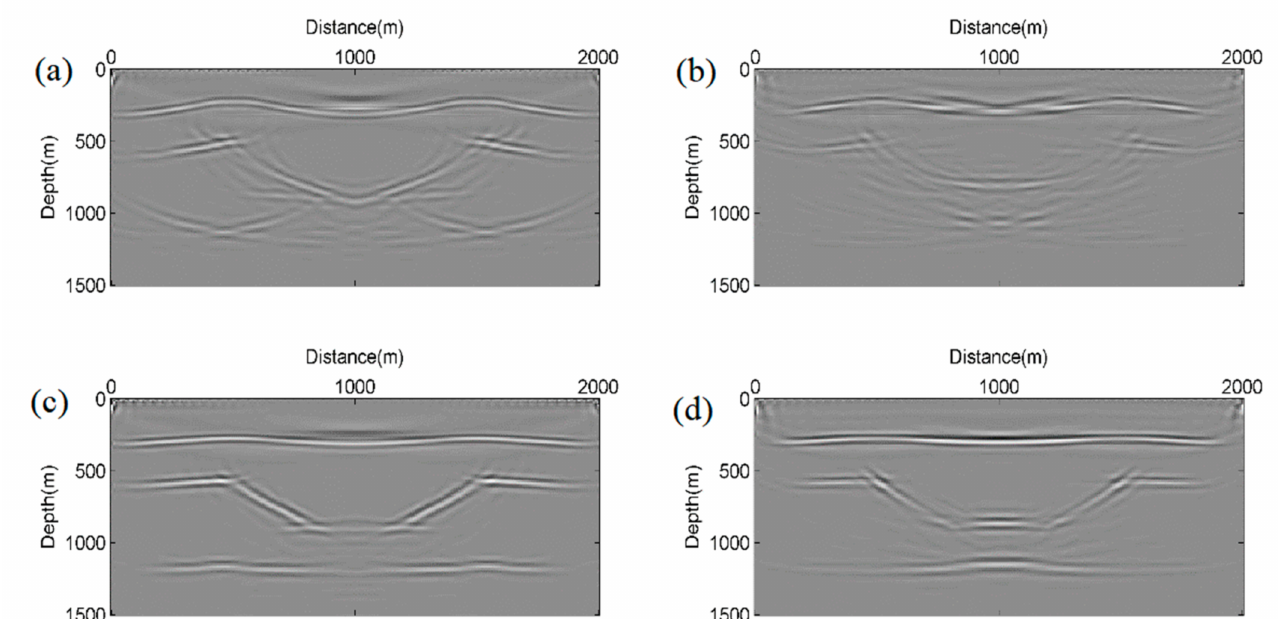
Figure 10. Migration images using data from models with different topographies. The left panels are the PP-wave images, and the right panels are the PS-wave images. The surface topography is not considered during ERTM. Panels ( a , b ) are the migration images using data from the model with a sinusoidal topography, and panels ( c , d ) are the migration images using data from the model with a triangular